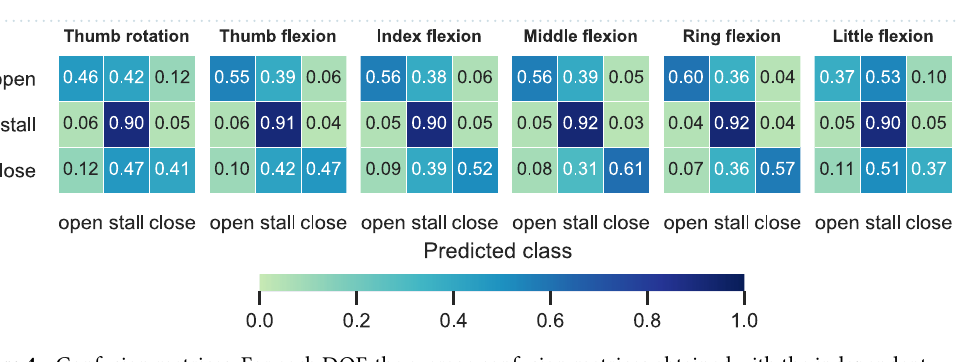
Table 2. Classifier benchmark. Median scores and overall ranges are reported for each classifier using the independent multi-output strategy. Bold values indicate highest average performance for each evaluation metric.